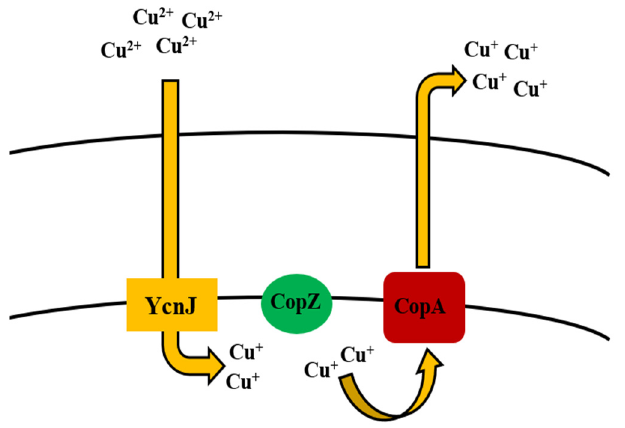
Figure 6. Uptake and efflux mechanism of copper by Bacillus spp.